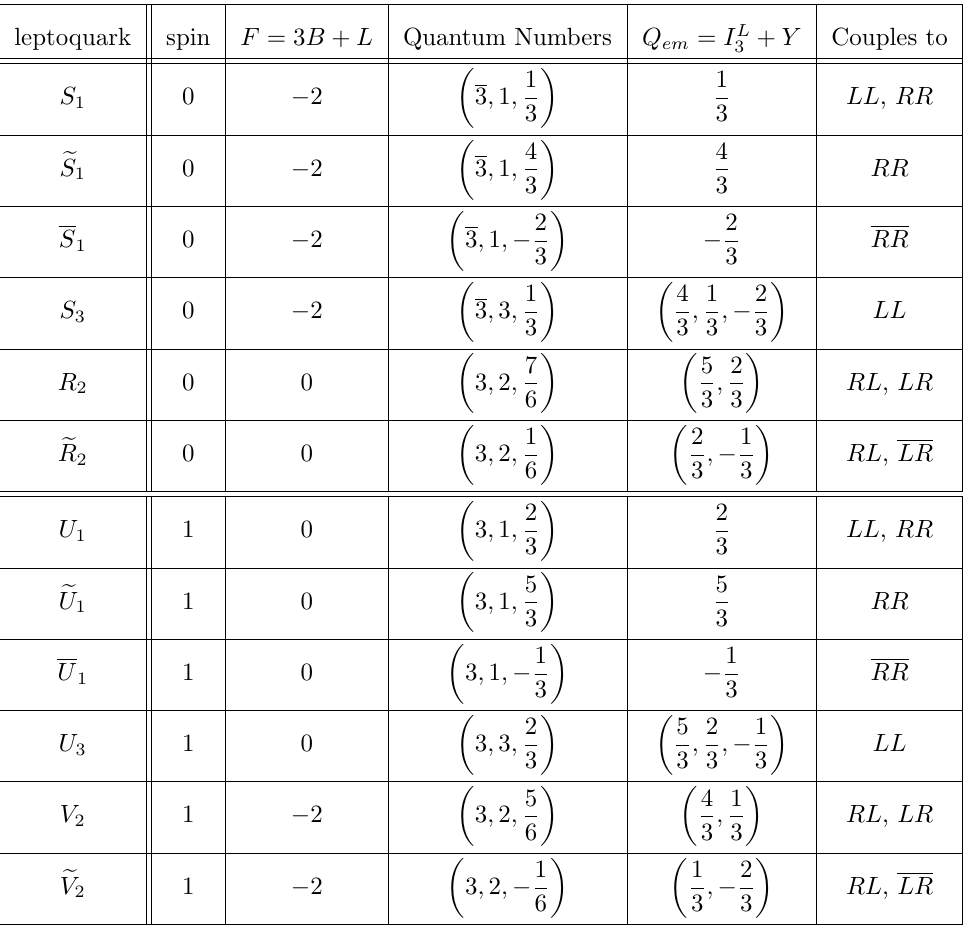
Table 7 . Quantum numbers of scalar and vector leptoquarks with SU(3) C (cid:2) SU(2) L (cid:2) U(1) Y invariant couplings to quark-lepton pairs. F = 3 B + L is the fermion number and the hypercharge Y is normalized so that Q em = I L + Y . The (cid:12)nal column indicates the chiralities of the quark 3 and lepton (cid:12)elds that each leptoquark couples to, with the (cid:12)rst letter of the pairs indicating the chirality of the quark (cid:12)eld and the second letter indicating that of the lepton (cid:12)eld. Pairs with a bar over them indicate that the right-handed lepton involved in the pair is a right-handed neutrino. Here, the couplings between the vector/scalar leptoquarks and the fermions are denoted respectively by x and y . The (cid:12)rst subscript indicates the isospin of the leptoquark and the latter two the generations of the fermions involved. The superscripts denote the chiralities of the fermions, with a bar placed over the chiralities when a right-handed neutrino is involved.